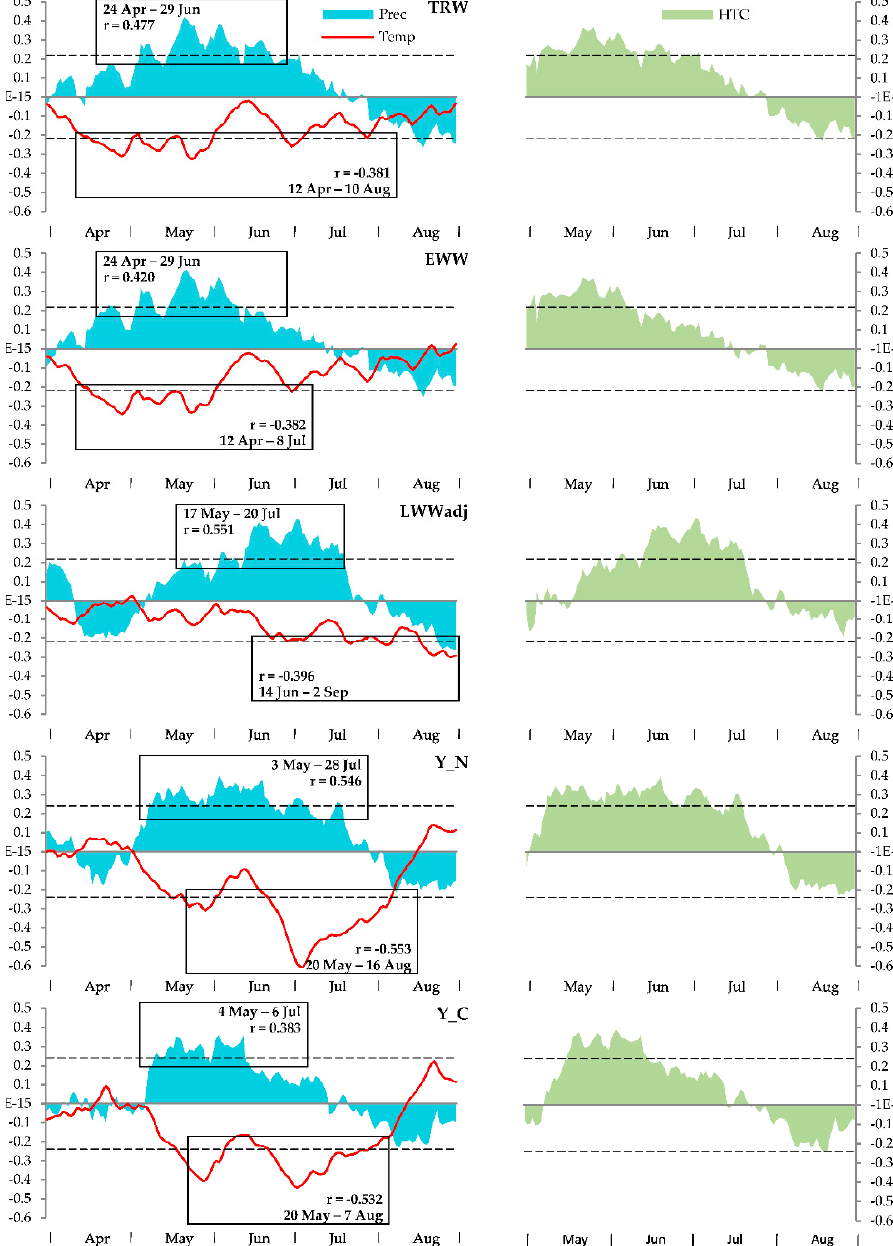
Figure 3. Climatic response of larch tree-ring parameters (TRW, EWW, and LWWadj) and crops yield generalized for Northern zone (Y_N) and Central zone (Y_C): correlations with centered 21-day moving series of average temperature (Temp; lines), sum of precipitation (Prec; shaded areas in the left column) from April to August, and of hydrothermal coefficient (HTC; shaded areas in the right column) from May to August. Dashed horizontal lines represent significance level p = 0.05. Rectangles mark periods when climatic factors have maximum correlations with respective yield series.